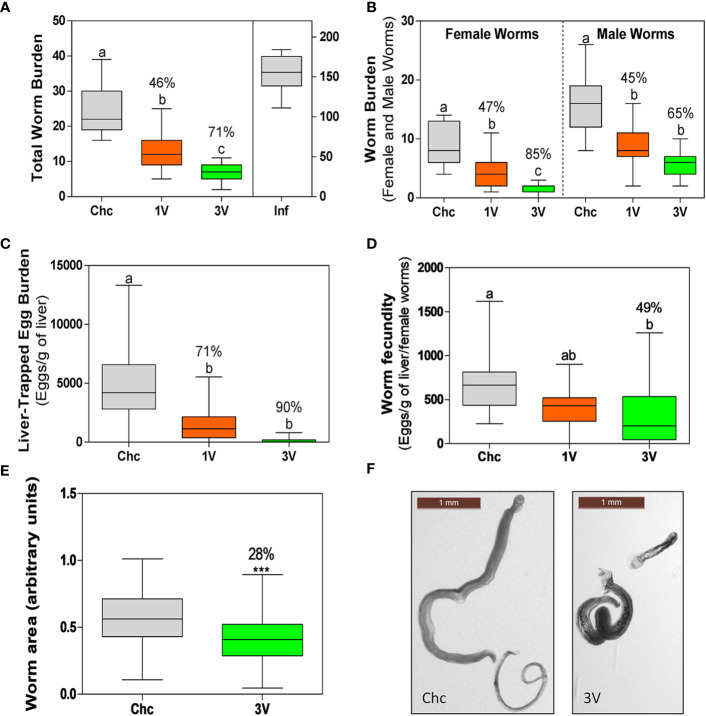
Parasitological parameters of the longitudinal assay➁. (A) Total worm burden and protection (%) for one-vaccine dose (1V) and three vaccine doses (3V) in comparison to challenge control (Chc). The Inf group was infected with 500 normal cercariae. (B) Worm burden separated by schistosome gender (male and female worms) and protection (%) in comparison to Chc. (C) Liver-trapped eggs and (D) Egg load per gram of liver per female. The percentage protection is presented for 1V and 3V groups in relation to the challenge control (Chc). (E) Worms with impaired development recovered from mice vaccinated with three doses (3V) (***P < 0.001). Area was measured for 177 worms from Chc and 101 worms from 3V, using the ImageJ program. (F) Representative images of worms of the Chc and 3V groups. Box plots with different letters represent significant differences and box plots sharing at least one letter represents no significant difference by ANOVA, Tukey (p<0.05); the Inf group was not included in this analysis. Data collected from longitudinal assay➁ (15 mice per experimental group) and representative of two additional longitudinal assays➀ and ➂ (detailed in
Supplementary Figure 2
).